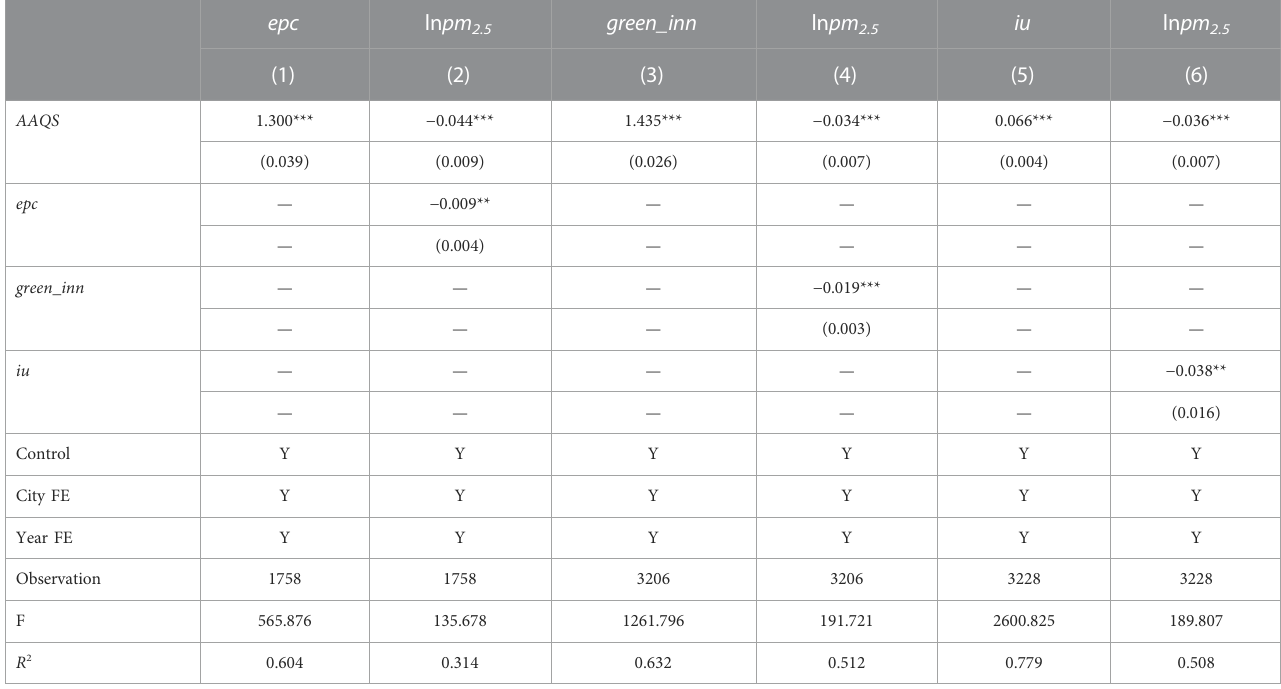
TABLE 5 Mechanisms of public environmental information disclosure reducing air